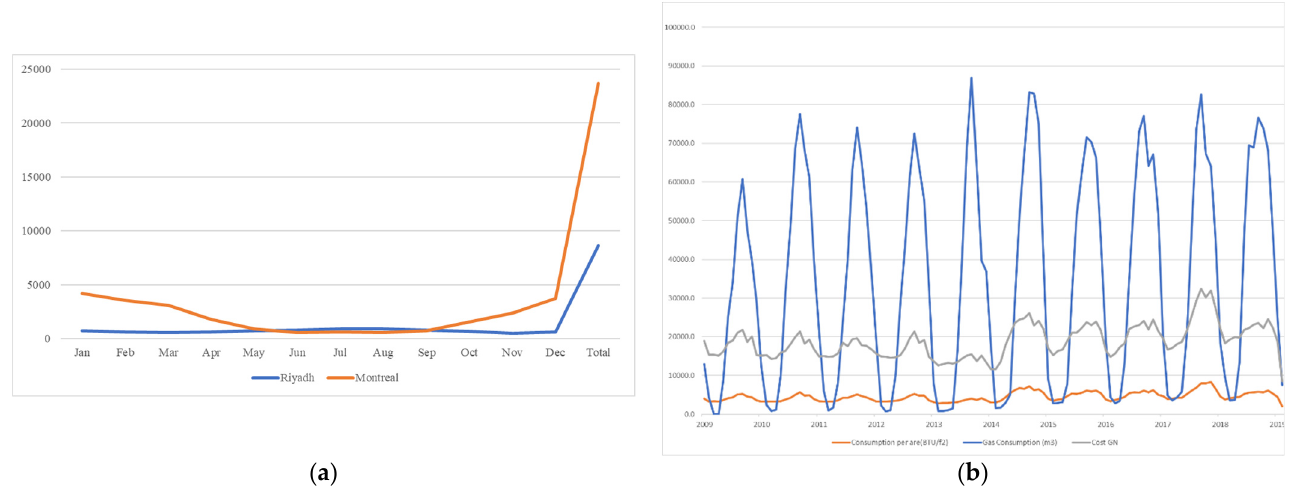
Figure 3. Chart for total energy consumption. ( a ) Chart for total energy consumption for Riyadh and Montreal in MWh. ( b ) Grey Nuns Building—total energy consumption.